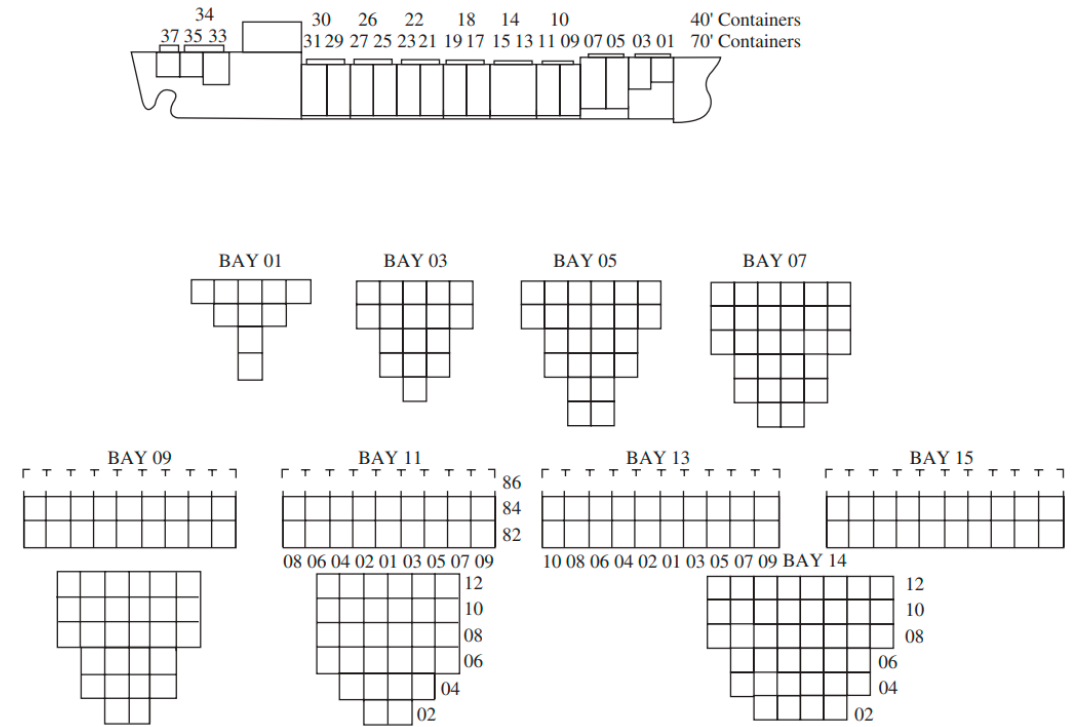
Figure 3. An example of a vessel stowage plan.